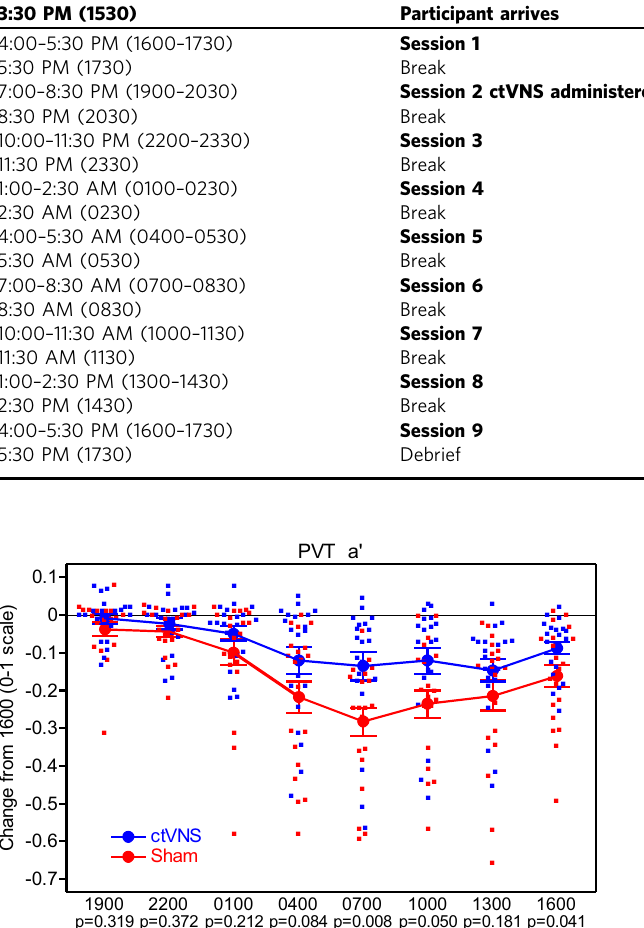
Table 1 Testing schedule for each participant and procedures within each session. Time, standard and (military)